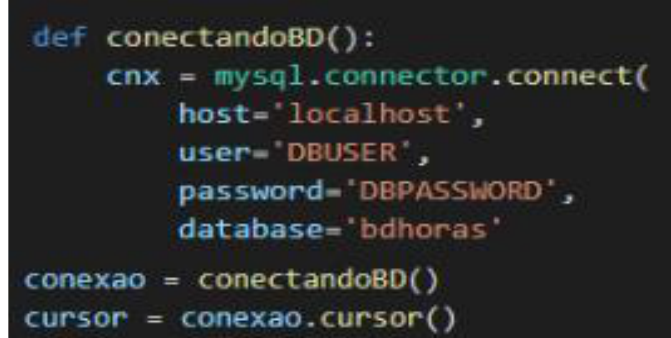
Figure 6: Database connection function and instance. Source: Authors,